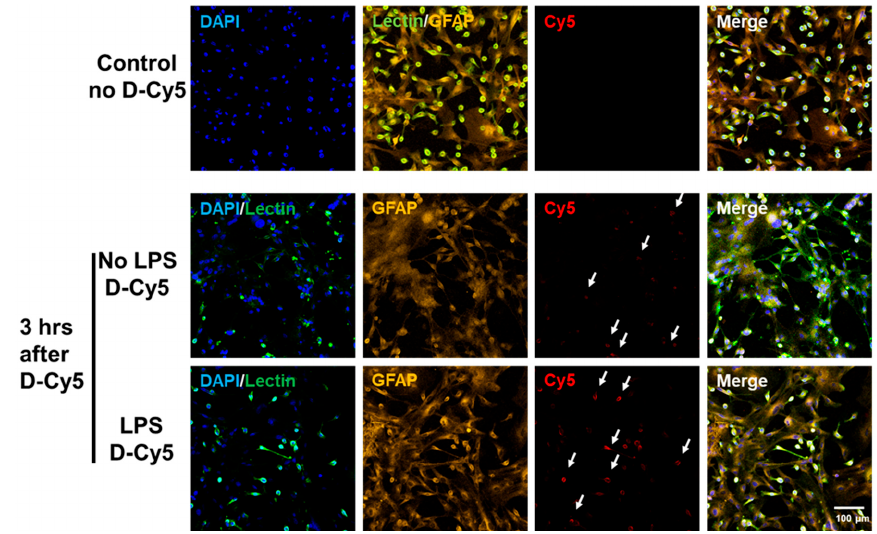
Figure 2. Preferential and selective cellular uptake of G4-OH dendrimers (D-Cy5) activated microglia/macrophages. Cy5-labeled D4-OH PAMAM dendrimers ( D-Cy5 ) were used to evaluate the selective uptake of dendrimers by microglial cells. Microglial cells stained with lectin (Green), Astrocytes were stained using GFAP (Orange), and nuclei were stained using DAPI (Blue). The activated microglial cells (LPS) group demonstrated a higher number of microglial +VE for dendrimers ( D-Cy5 , white arrows) compared to resting microglia (No LPS). Interestingly, the signal intensity of D-Cy5 is higher in activated microglial cells compared to the D-Cy5 intensity in resting microglial cells, suggesting higher amount of dendrimer uptake. The signal intensities for all channels are kept constant for all conditions. DAPI/Lectin channel is used to better demonstrate the microglia/macrophage population in mixed glia culture taken-up dendrimers, as shown in Cy5 channel. Scale bar 100 μ m.